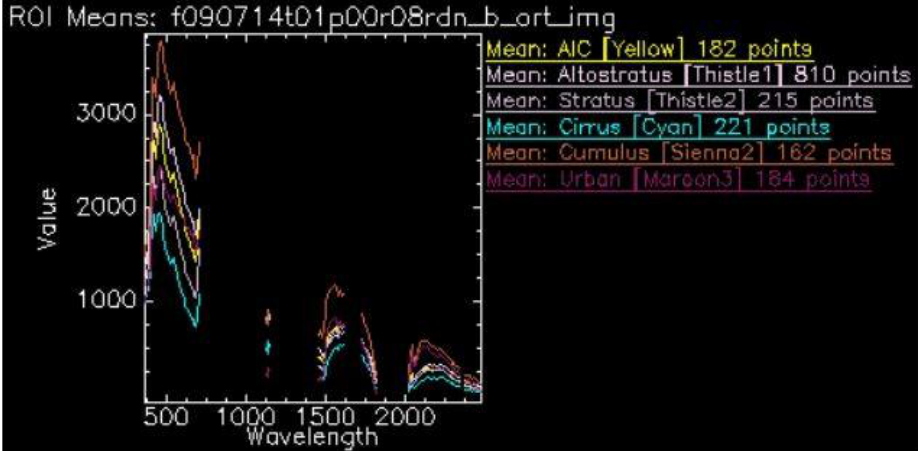
Figure 3. ROI spectral signatures with bad bands for five cloud types and developed area.